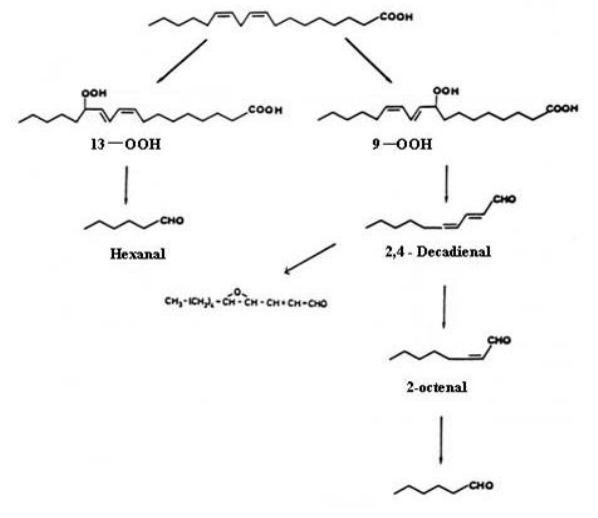
Figure 3. Oxidation and degradation products of linoleic acid (Shi and Ho,